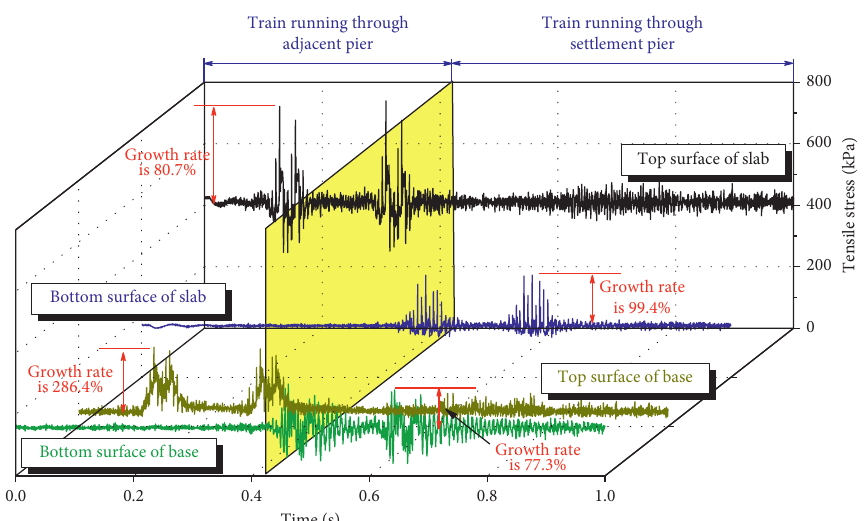
Figure 9: Dynamic additional tensile stresses at different locations when train is running through.